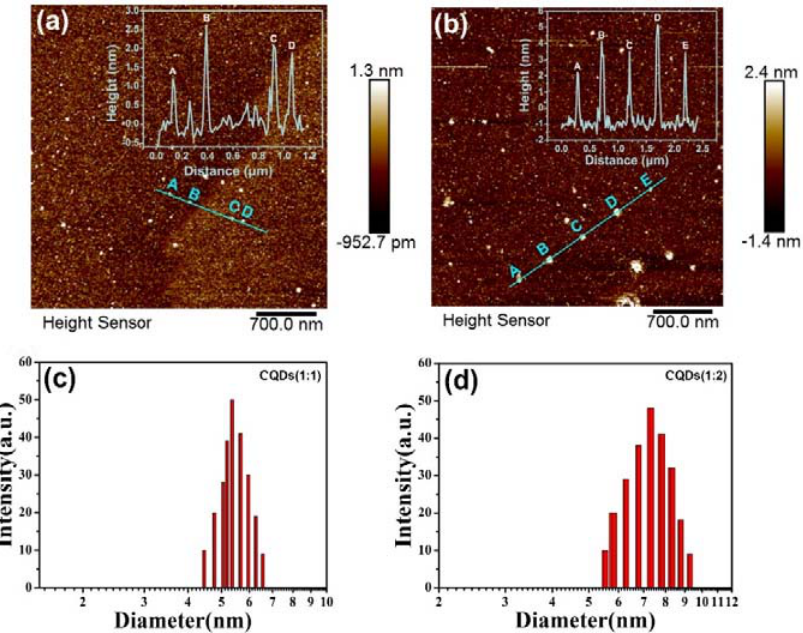
Figure 3. ( a , b ) Atomic force microscopy (AFM) images of CQDs (1:1) and CQDs (1:2) deposited on a silicon slice (inset: the height profile along the line in the topographic image of the CQDs (1:1) and CQDs (1:2), respectively); ( c , d ) Dynamic light scattering (DLS) images of CQDs (1:1) and CQDs (1:2).